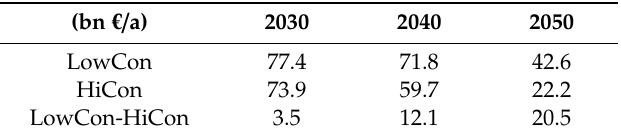
Table 3. Variable costs of electricity generation in the ENTSO-E area.